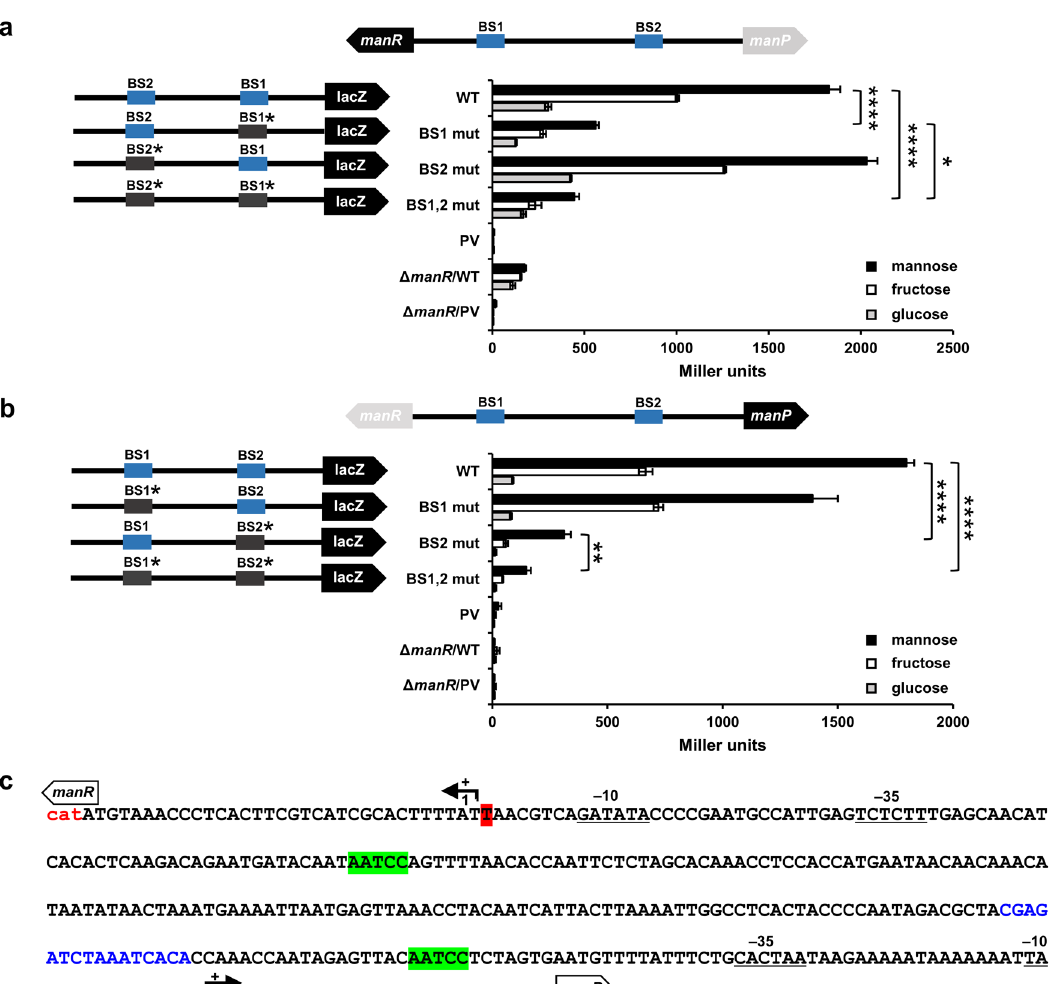
Fig. 4 ManR binding to each binding site (BS) activates the expression of itself and the man operon. a , b The effect of ManR binding to each BS on the transcriptional activation of manR ( a ) and manP ( b ) was measured by the lacZ reporter assay using a V. cholerae N16961 Δ lacZ strain or Δ lacZ Δ manR strain harboring a plasmid carrying E. coli lacZ transcriptionally fused with the wild-type or mutated binding site (mutated site indicated as BS# mut). Schematic representation of plasmids is shown on the left, with mutation site depicted by a gray box and star. Indicated strains were grown on mannose, fructose, or glucose and then lysed to measure the β -galactosidase activity (right panel). The means and standard deviations of three independent measurements are shown. Statistical signi fi cance was determined using the Student ’ s t - test (* P < 0.05, ** P < 0.005, and **** P < 0.0001). c Nucleotide sequence of the manR – manP intergenic region. The AATCC sequences of ManR- binding sites are highlighted in bright green. The transcription start sites (TSSs) of manR and manP are highlighted in red and marked with bent arrows. The − 35 and − 10 elements of the manR and manP promoters are underlined, respectively. The initiation codons of manR and manP are shown in red lower case letters. The putative cyclic AMP (cAMP) receptor protein (CRP) binding site is shown in